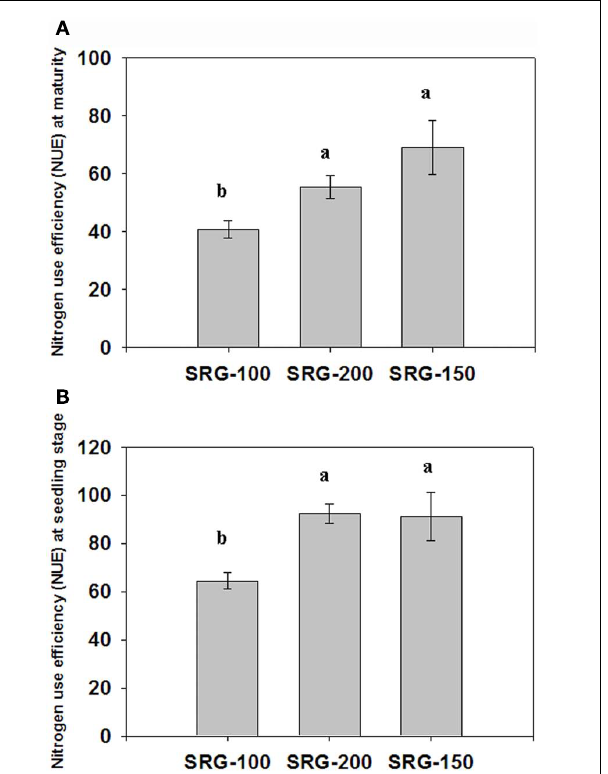
FIGURE 1 | Nitrogen Use efficiency (NUE) in the hybrid SRG-150 and its parent lines SRG-100 and SRG-200 under nitrogen limitation condition. (A) at maturity stage in greenhouse experiment; (B) at early seedlings stage (4weeks old) in hydroponic system (calculated in the plants growing under N limitation). Data are means ± SD ( n = 3 each replicate represent four plants). Bars with different letters indicate a significant difference at P ≤ 0.05 (Tukey’s Honestly Significant